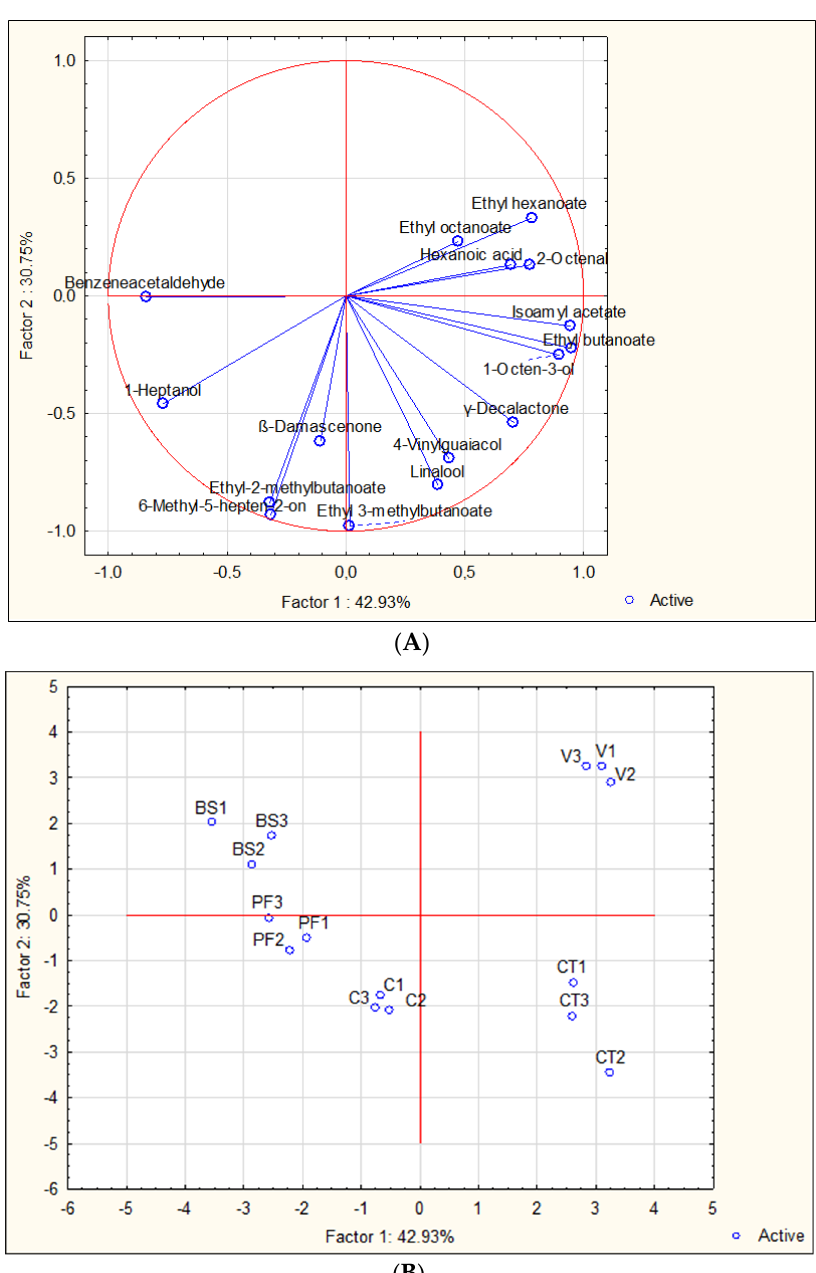
Figure 2. PCA performed using the concentrations of 16 volatile compounds with OAV > 1 discriminated among wine samples produced from five canopy-management treatments. ( A ) Projections of 16 volatile characteristics based on latent PC factors 1 and 2, which together explained 73.68% of total variability. ( B ) Principal component analysis (PCA) of 15 wines (C1, C2, C3: control; V1, V2, V3: defoliation at veraison; CT1, CT2, CT3: cluster thinning; PF1, PF2, PF3: defoliation at preflowering; and BS1, BS2, BS3: defoliation at berry set) on the plane defined by the first two principal